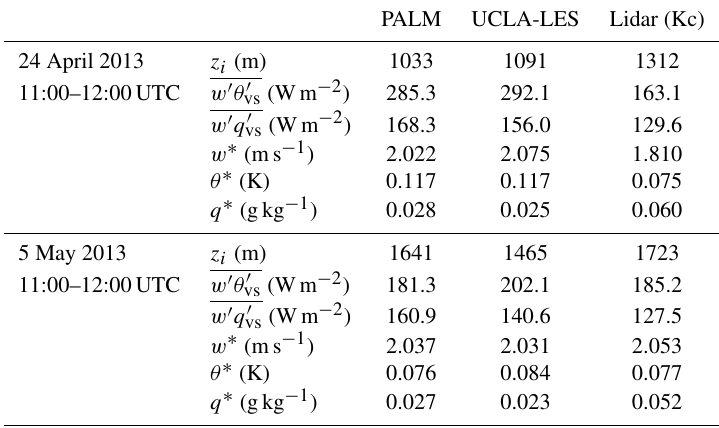
Table 3. Scaling values for 24 April 2013 and 5 May 2013 for 11:00–12:00UTC (used in Fig. 9).